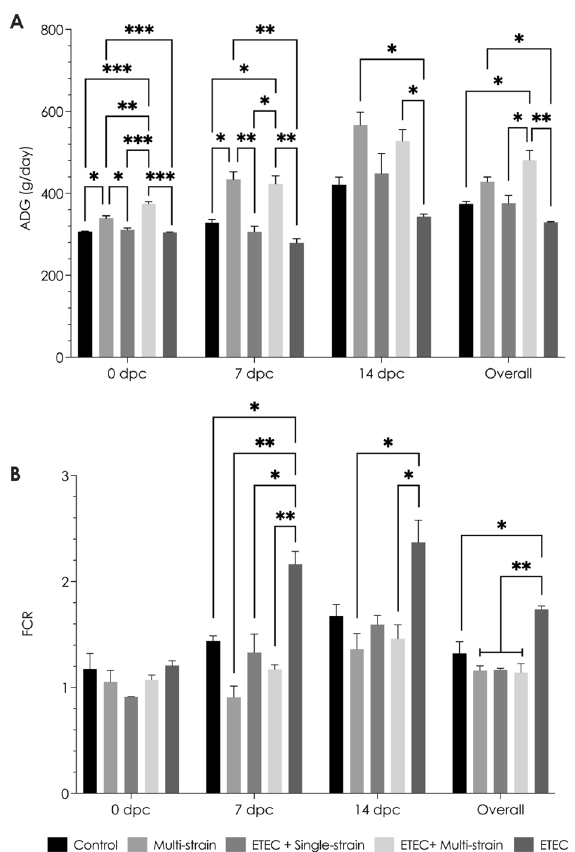
Figure 2. Growth performance of piglets after ETEC challenge (5 × 10 9 CFU). ( A ) Average daily gain (ADG); and ( B ) Feed conversion ratio (FCR). Control = oral supplementation of sterile peptone water followed by oral administration of sterile peptone water; Multi-strain = oral supplementation of double-coated multi-strain probiotic followed by oral administration of sterile peptone water; ETEC + Single-strain = oral supplementation of double-coated single-strain probiotic followed by oral challenged with ETEC; ETEC + Multi-strain = oral supplementation of double-coated multi-strain probiotic followed by oral challenged with ETEC; and ETEC = oral supplementation of sterile peptone water followed by oral challenge with ETEC. Values are presented as mean ± SEM of all replications in each group. The asterisks represent statistically significant differences (* P < 0.05, ** P < 0.01 and *** P < 0.001). dpc = day